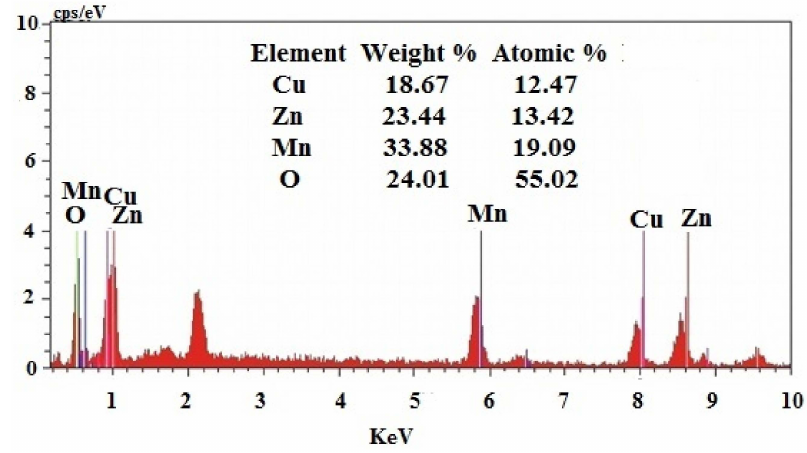
Figure 4. EDAX of Cu-Zn-Mn mixed trimetal oxide nanoparticles.